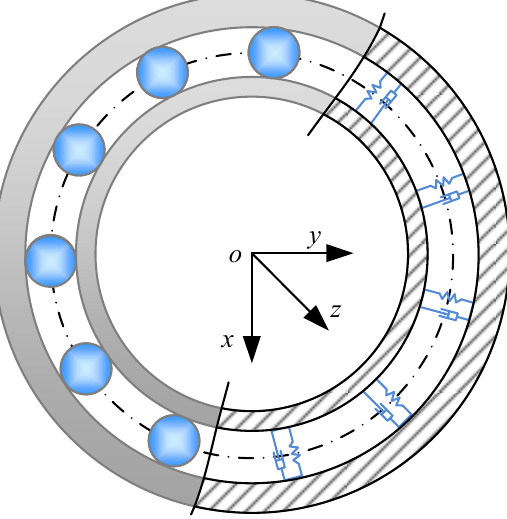
Figure 3. Schematic diagram of the spring-damping model.